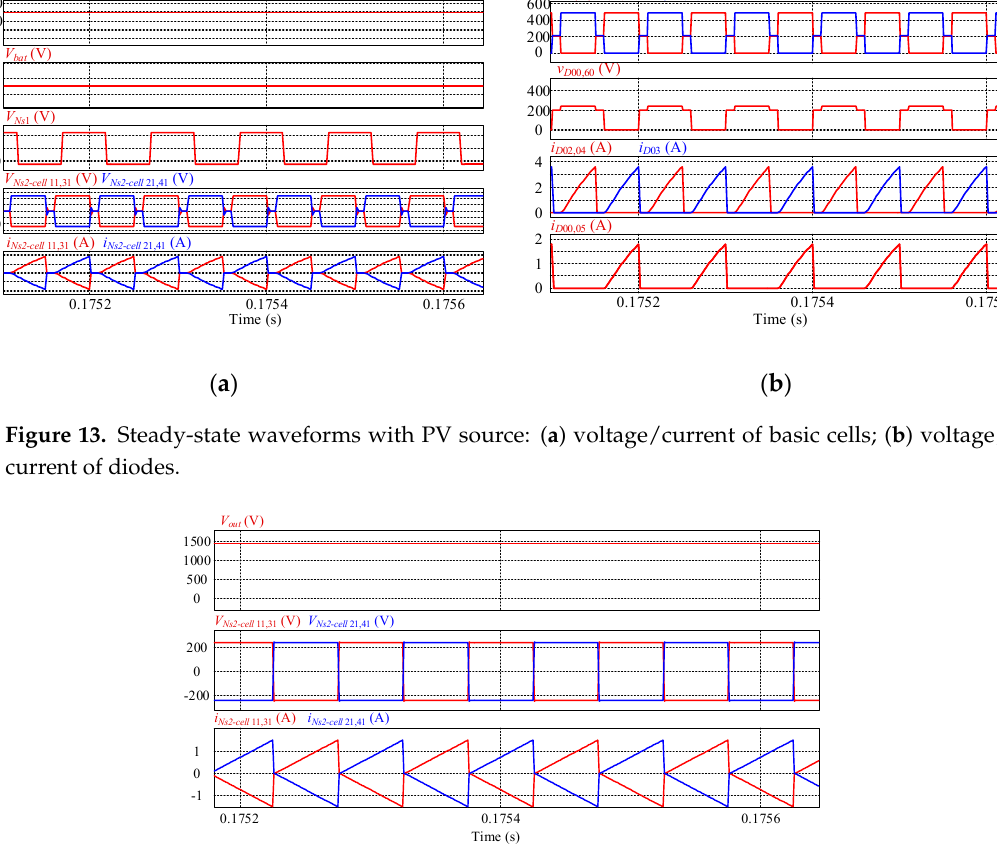
Figure 14. Steady-state waveforms of voltage/current of basic cells without PV source.